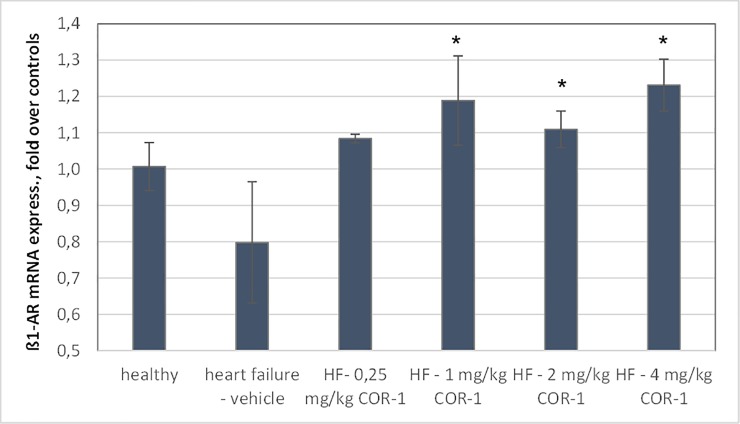
Cardiac mRNA levels of ß1-adrenergic receptors (ß1-AR) of healthy rats and HF rats treated with either vehicle or COR-1.Means ± SEM of the normalized ß1-AR mRNA (ratio of ß1-AR R mRNA divided by the respective GAPDH mRNA level) of HF rats after ten treatments (20 months after the first immunization), including the groups which had been treated with vehicle (n = 5), or 0.25 mg/kg COR-1 (n = 4), 1 mg/kg COR-1 (n = 10), 2 mg/kg COR-1 (n = 5), or 4 mg/kg BW COR-1 (n = 9), respectively. For comparison, mean normalized ß1-AR mRNA levels are also shown for healthy control rats (n = 6). * indicates statistical significance (p<0.05 by ANOVA), compared to the HF vehicle group.